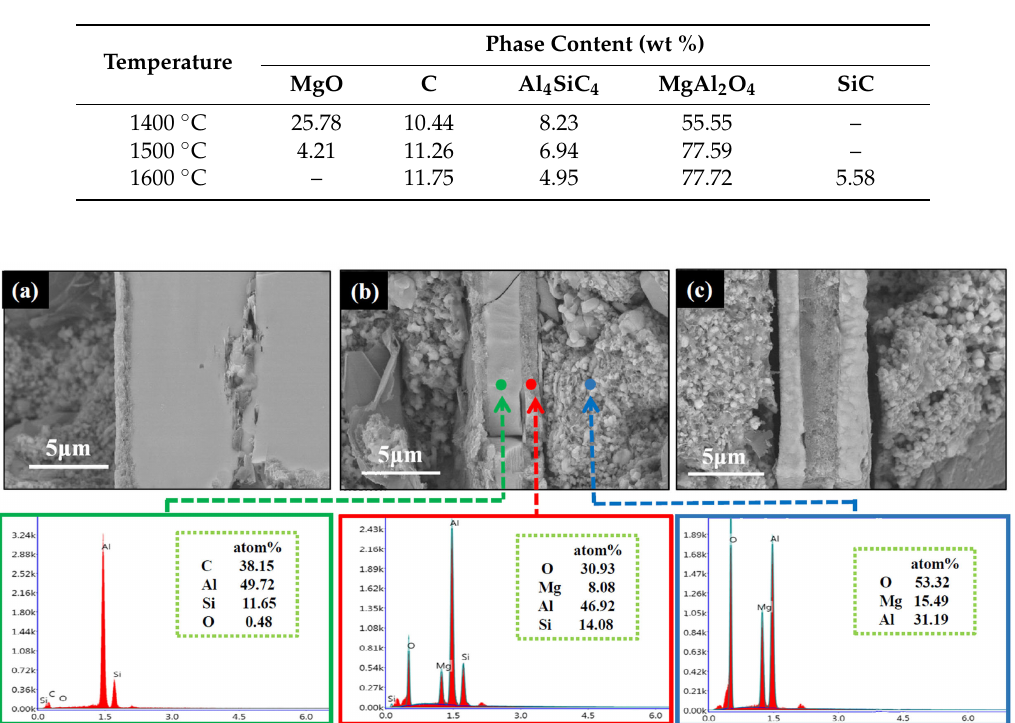
Figure 4. Structure evolution of Al 4 SiC 4 crystals at different temperature: ( a ) 1400 °C; ( b ) 1500 °C and ( c ) 1600 °C.